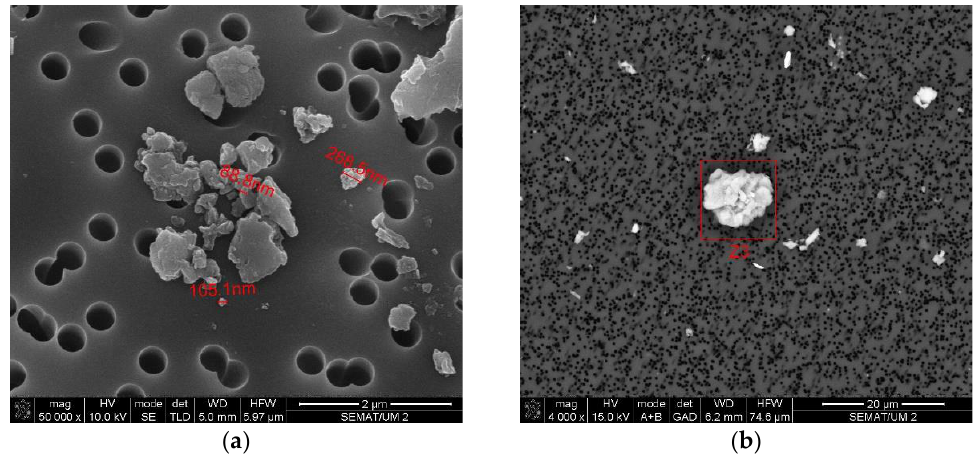
Figure 9. SEM analysis results: airborne sample collected on polycarbonate filter. ( a ) Size and shape of particles in the sample; ( b ) image of the particle analyzed by EDS (results in Figure 10).